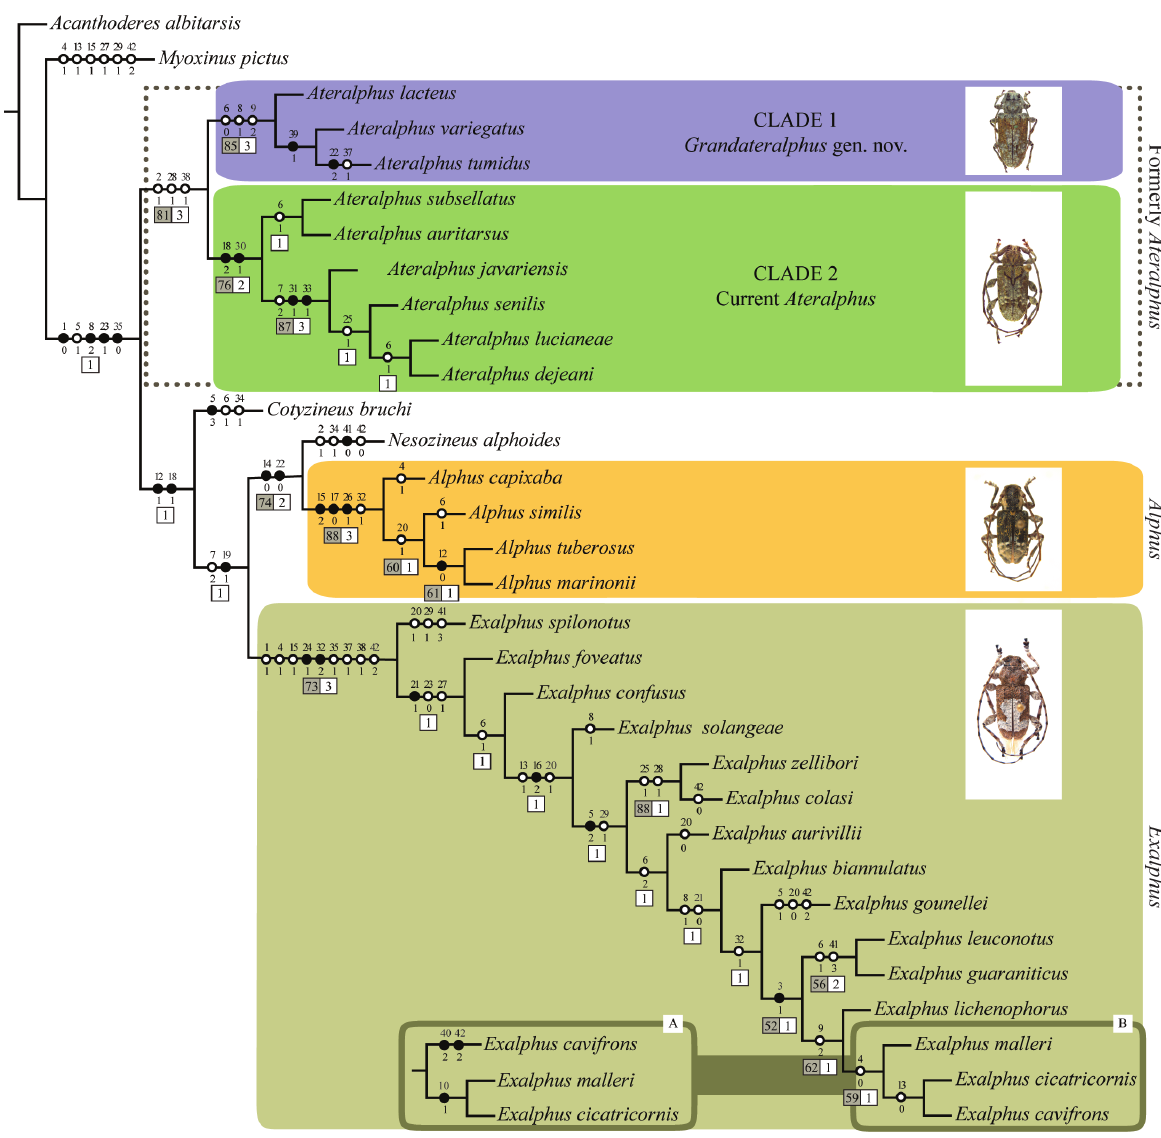
Figure 16. Tree obtained from the cladistics analysis of Ateralphus and related genera, Alphus and Exalphus . Only unambiguous transforma- tions are shown. A and B show the differences between the two most parsimonious topologies. Bootstrap (gray box) and Bremer support (white box) are indicated below each node. Clades are illustrated by the following species: Alphus similis Martins, 1985; Grandateralphus variegatus comb. n.; Ateralphus subsellatus ; and Exalphus leuconotus